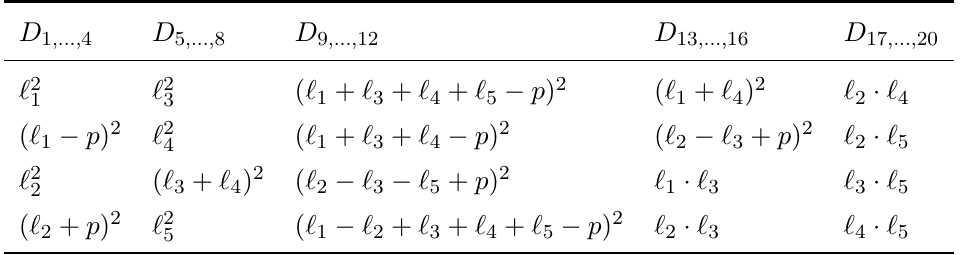
Table 1 . Inverse propagators D 1 , . . . , D 14 and numerators D 15 , . . . , D 20 for integral family P 46